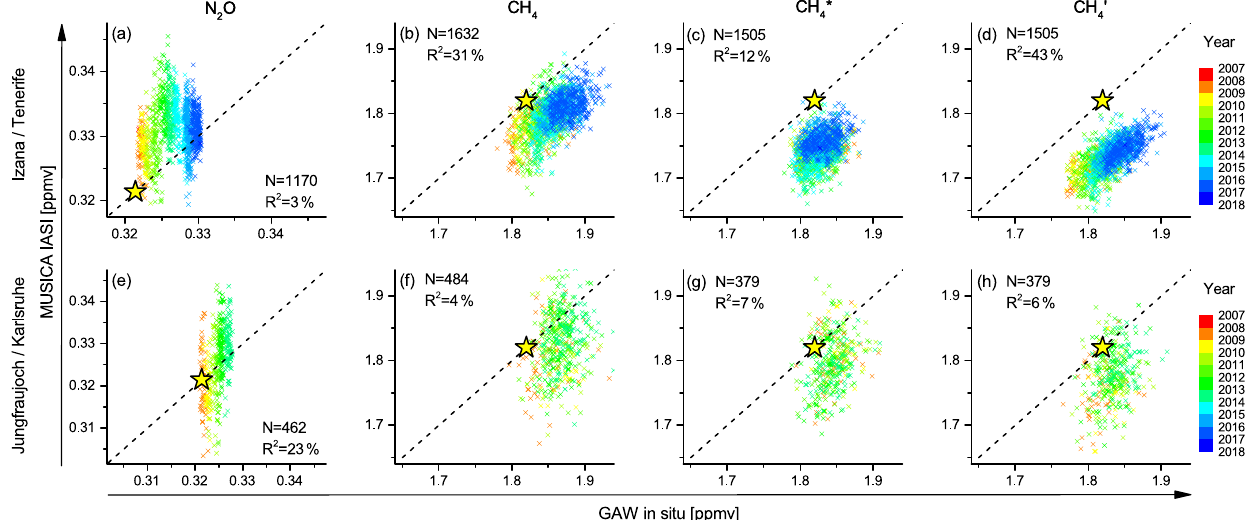
Figure 10. Correlation plots between daily night mean MUSICA IASI 4.2km retrieval products and GAW in situ data from high-mountain observatories: (a–d) for the surroundings of Tenerife Island; (e–h) for the surroundings of Karlsruhe; (a) and (e) for N 2 O; (b) and (f) for CH 4 ; (c) and (g) for CH ∗ ; and (d) and (h) for CH (cid:48) . A description of the CH ∗ and CH (cid:48) products is given in Table 2. The colour code indicates 4 4 4 4 the year of observation, the yellow star represents the a priori data used for the retrievals and the black dashed line is the one-to-one diagonal. Number of considered days ( N ) and R 2 values are given in each panel (all correlations are positive and significant on the 95% confidence level).